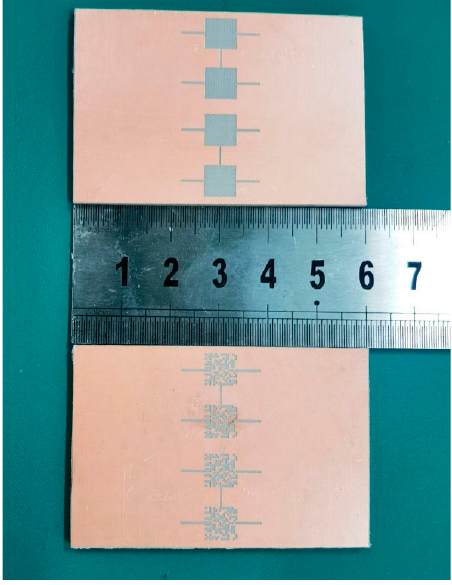
Figure 4. The fabricated differential microwave sensors (measurement unit: cm).